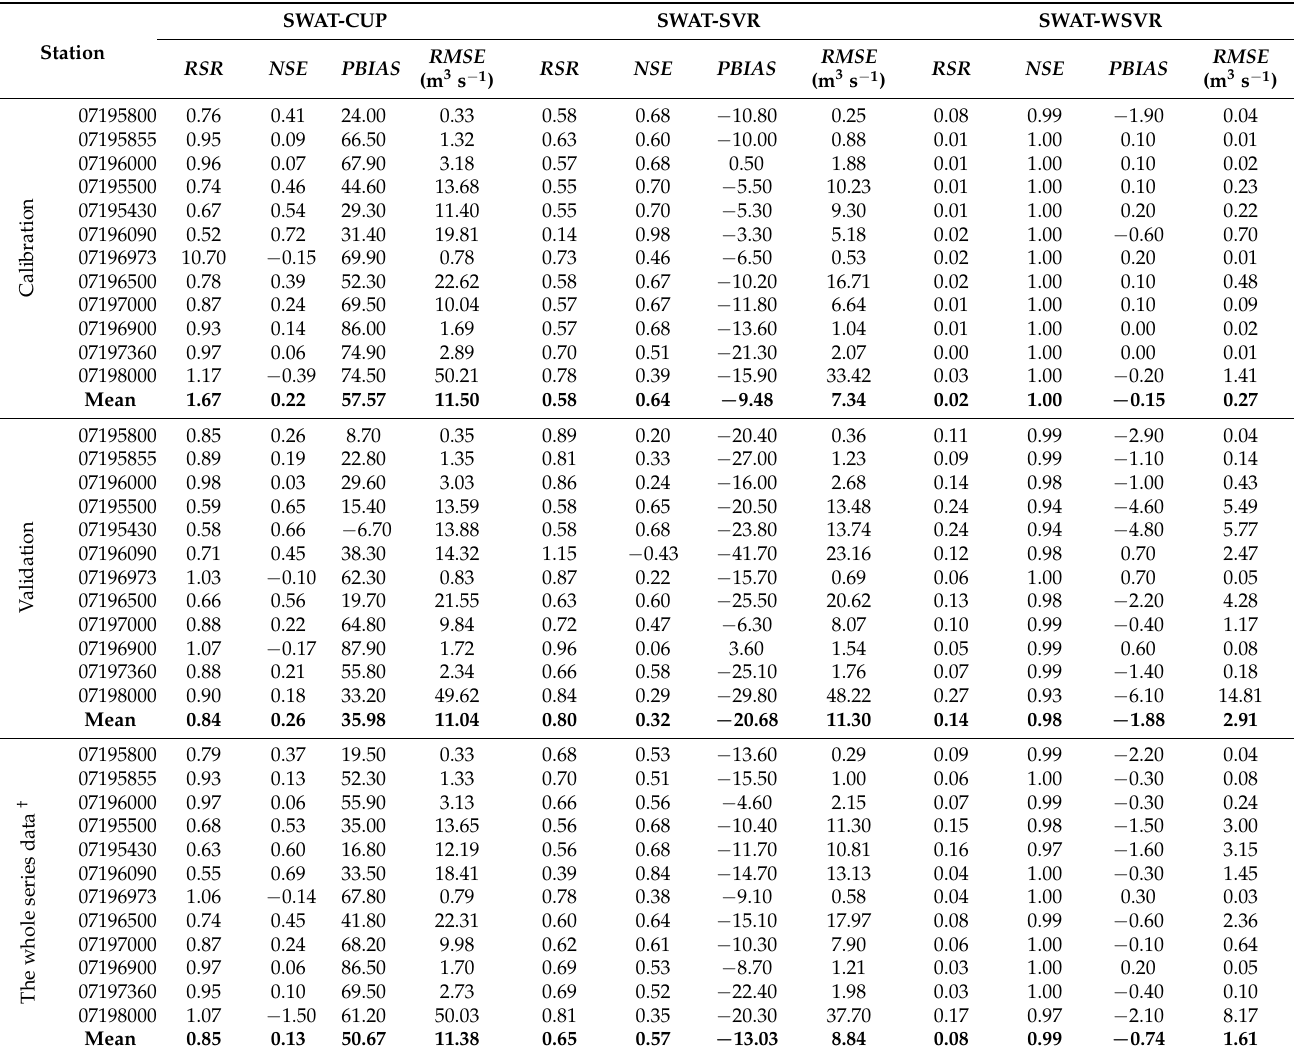
Table 4. Performance of flow calibration, validation, and combined data series on each site by SWAT-CUP, SWAT-SVR, and SWAT-WSVR.